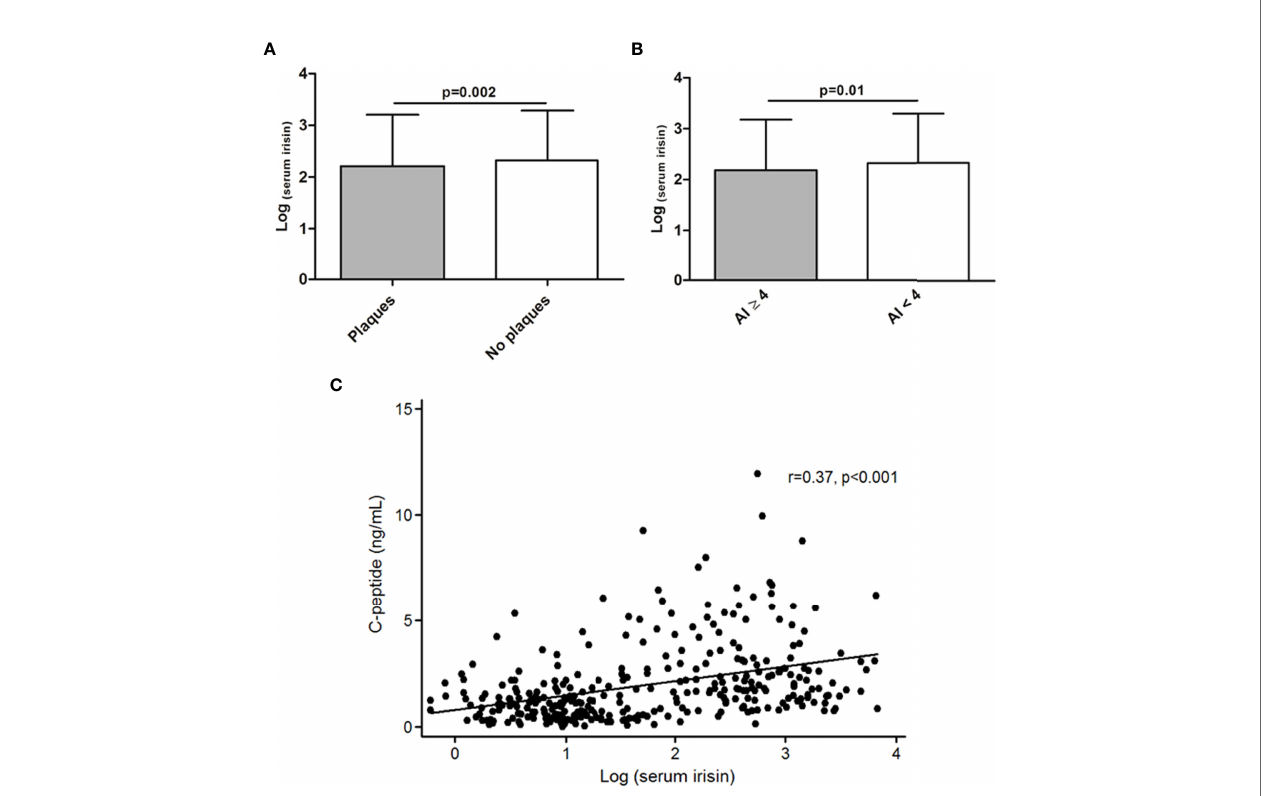
FIGURE 1 | Association of serum irisin levels and features related to subclinical atherosclerosis and cardiovascular disease-related features in axSpA. Lower levels of irisin in patients with carotid plaques (A) and in patients with an atherogenic index (AI) ≥ 4 (B) . Positive correlation between serum irisin and C-peptide levels (C) . Results shown in (A) and (B) were obtained after linear regression analysis, while results shown in (C) were obtained after Pearson ’ s partial correlation test, in all the cases adjusting for sex, age at the time of the study and classical cardiovascular risk